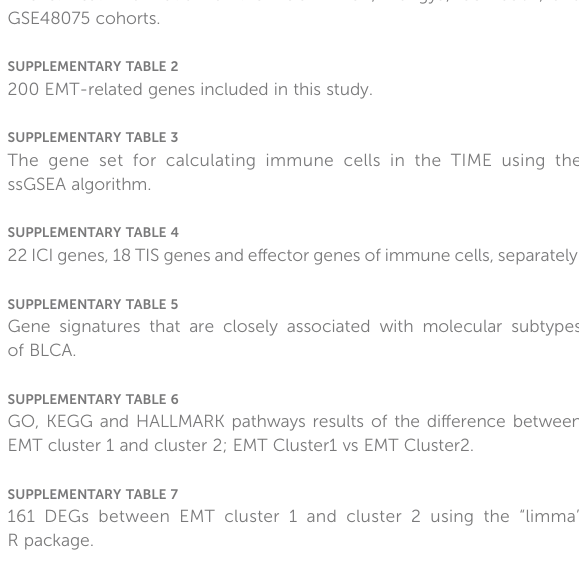
SUPPLEMENTARY TABLE 1 The clinical information of the TCGA-BLCA, Xiangya, GSE13507, and GSE48075 cohorts. SUPPLEMENTARY TABLE 2 200 EMT-related genes included in this study.